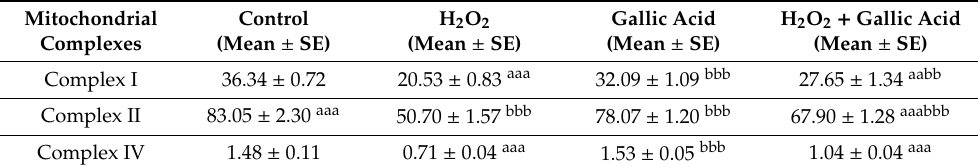
Table 1. Effects of gallic acid on the mitochondrial complexes’ activity of REF cells. Table 1. E ff ects of gallic acid on the mitochondrial complexes’ activity of REF